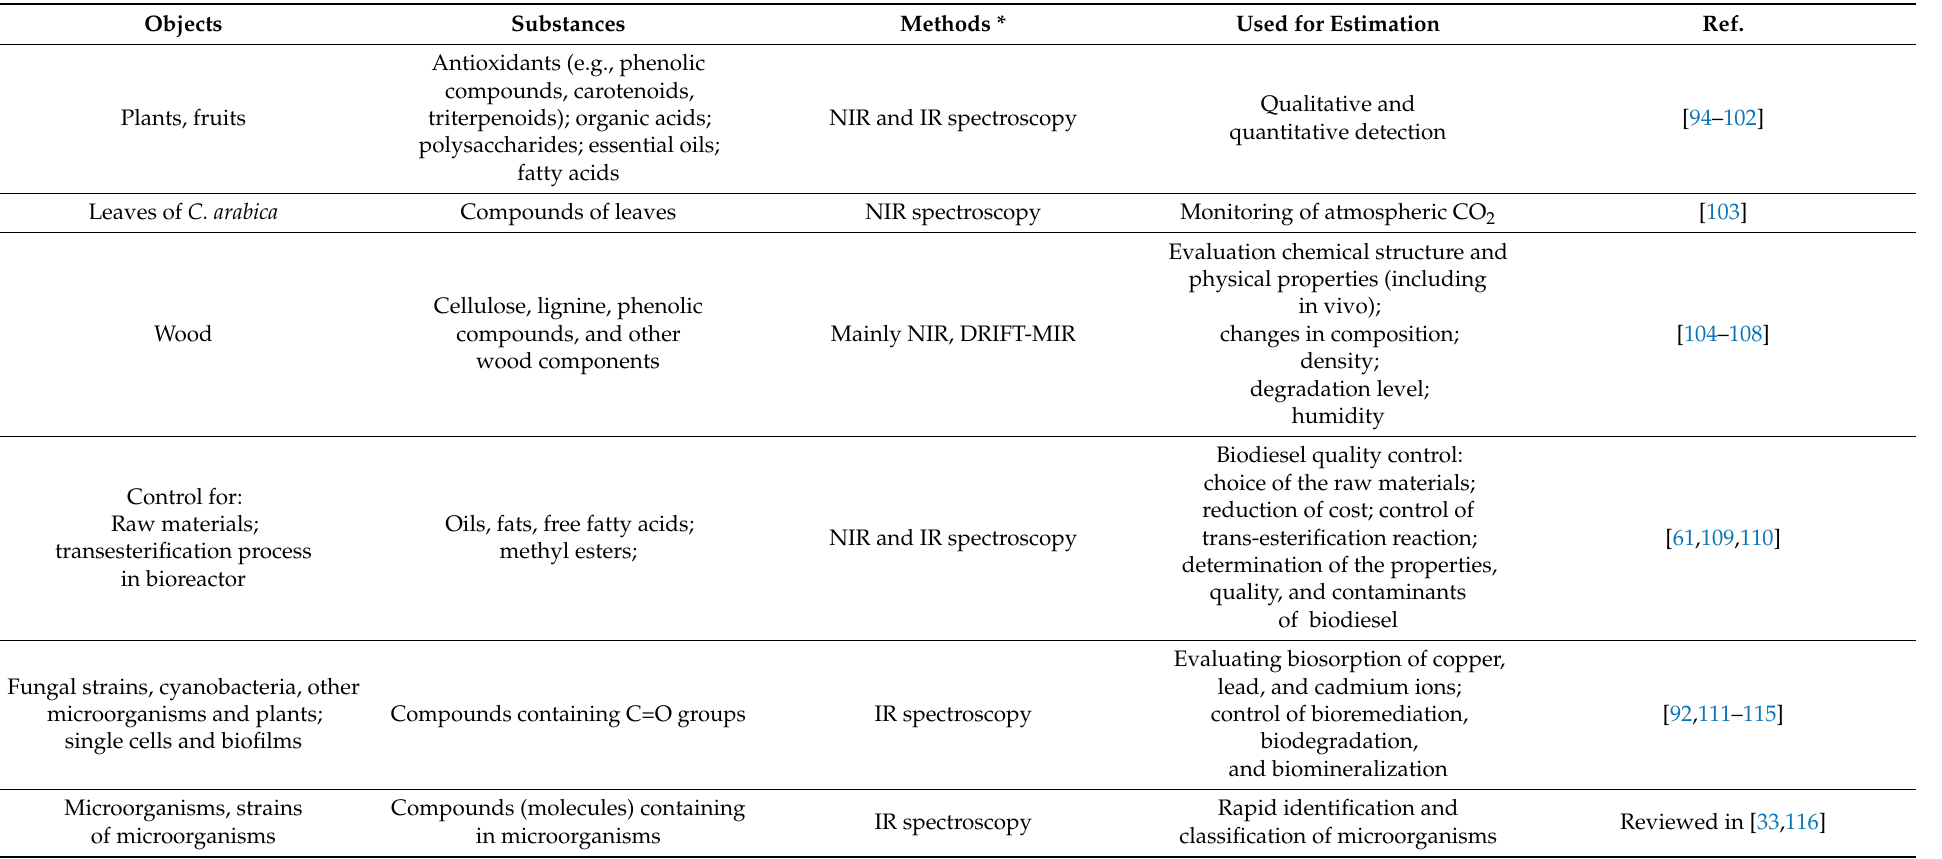
Table 4. Substances in cells observed using IR